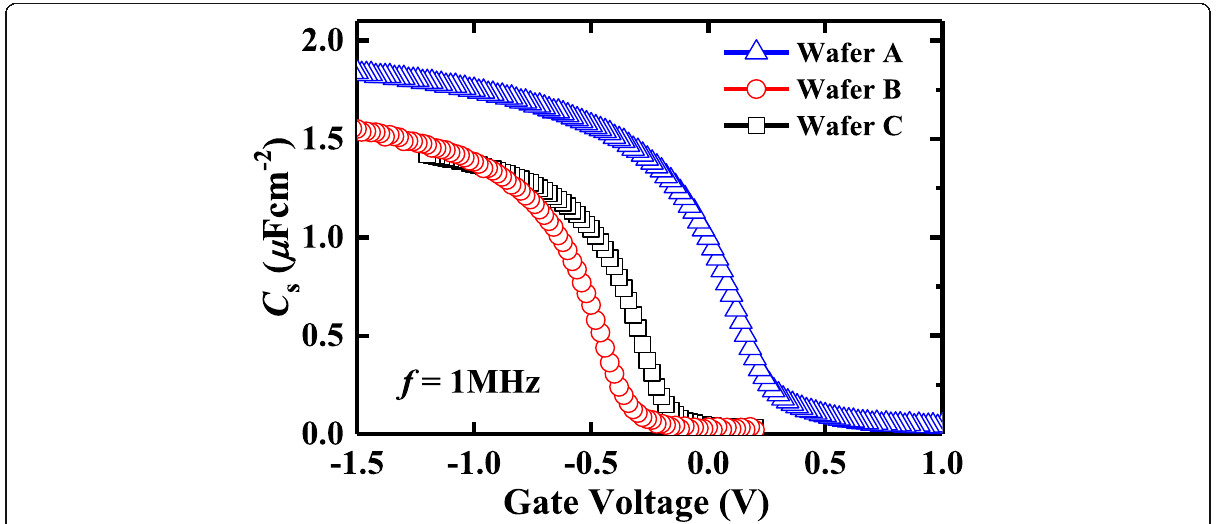
Fig. 6 Gate-to-source capacitance versus V GS characteristics of Ge pMOSFETs passivated by PPO (wafers A) and OPO (wafers B and